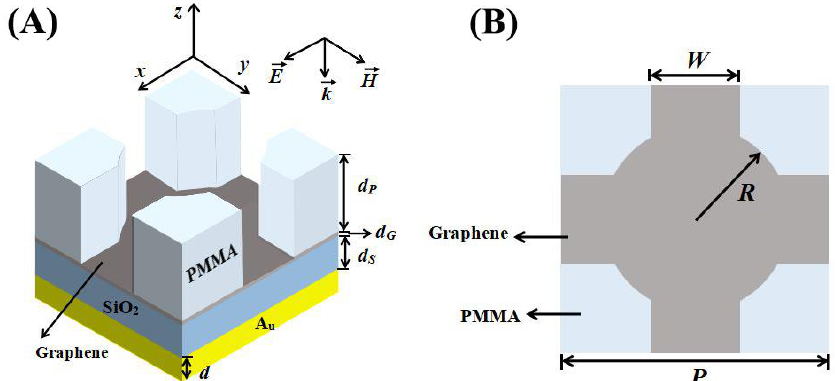
Figure 1. ( A ) Three-dimensional schematic diagram of the structure of the cross-circle-shaped periodic monolayer graphene unpatterned perfect absorber. The graphene layer was sandwiched between polymethyl methacrylate (PMMA) and SiO 2 layers. The fundamental parameters were: d P = 330 nm, d S = 240 nm, and d = 200 nm. ( B ) The corresponding top view with the specific geometric parameters shown in the figure. The fundamental parameters were: W = 400 nm, R = 500 nm, and P = 1250 nm.